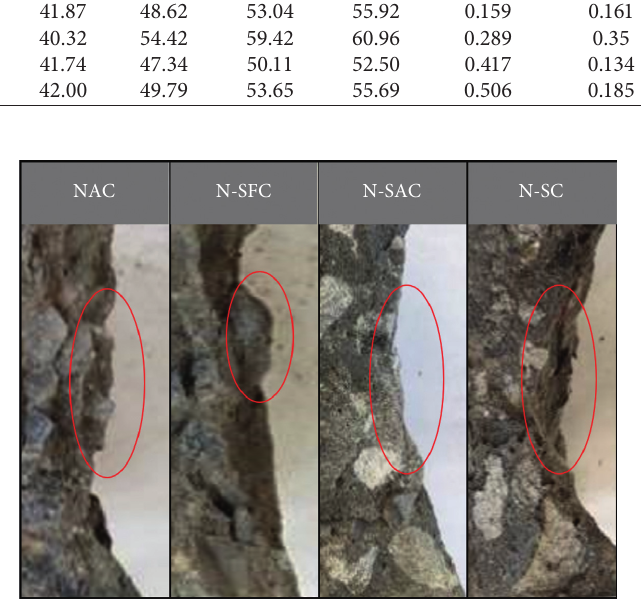
Figure 8: Destruction surface.